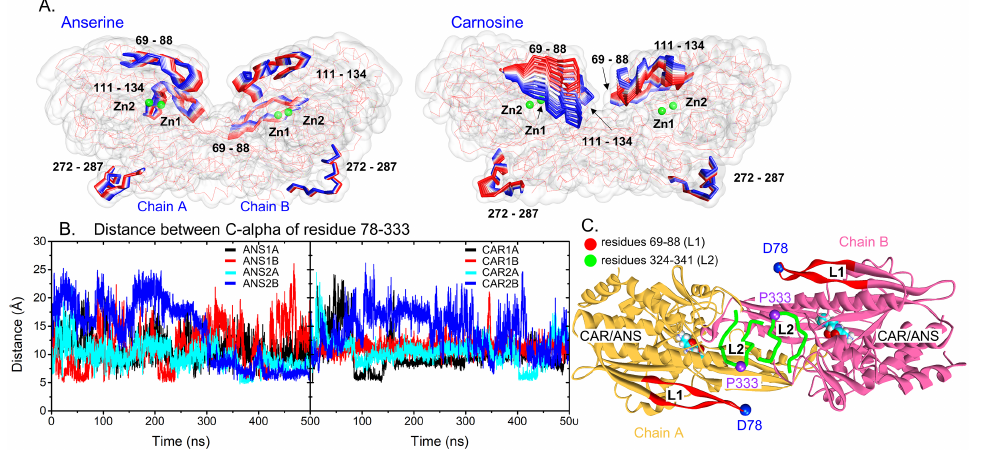
Figure 3 Protein dynamics. (A) Cartoon views of the time-dependent motions of anserine- and carnosine-bound CN1 calculated from the first principal component analysis. Only highly flexible regions with labels are shown in the RWB format where the displacements for t = 0 to t = 500 ns change from red to blue. Two Zn 2 + ions are also shown in green beads. (B) Distances between the C-alpha atoms of D78 and P333 in all systems (left: ANS and right: CAR). The locations of these two residues are shown in (C). The L1 and L2 loops are labelled in red and green. The ligands are displayed in Vdw format. Full-size DOI: